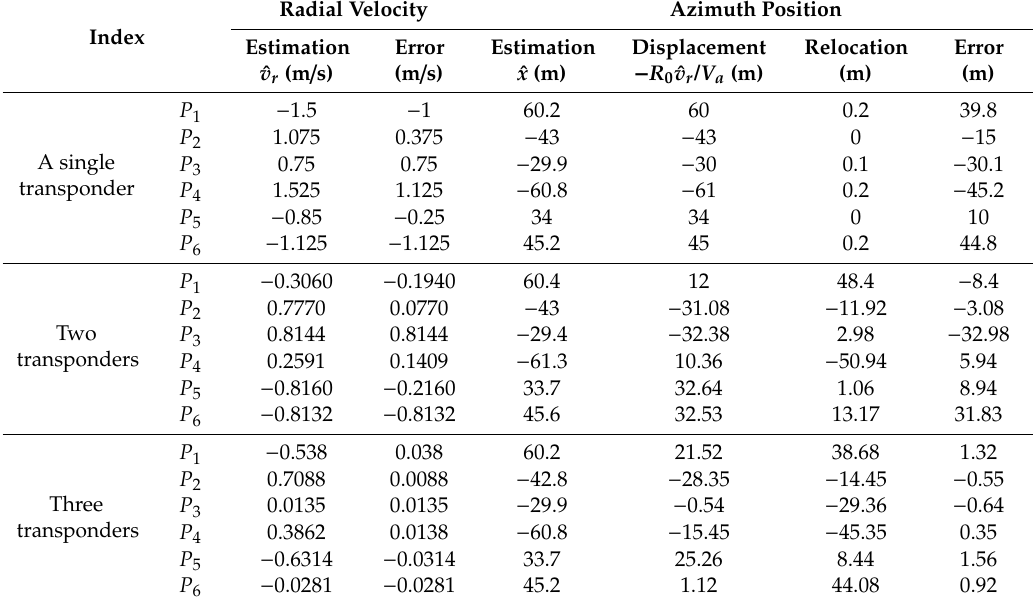
Table 3. Radial velocity and azimuth position of false targets with different combinations of